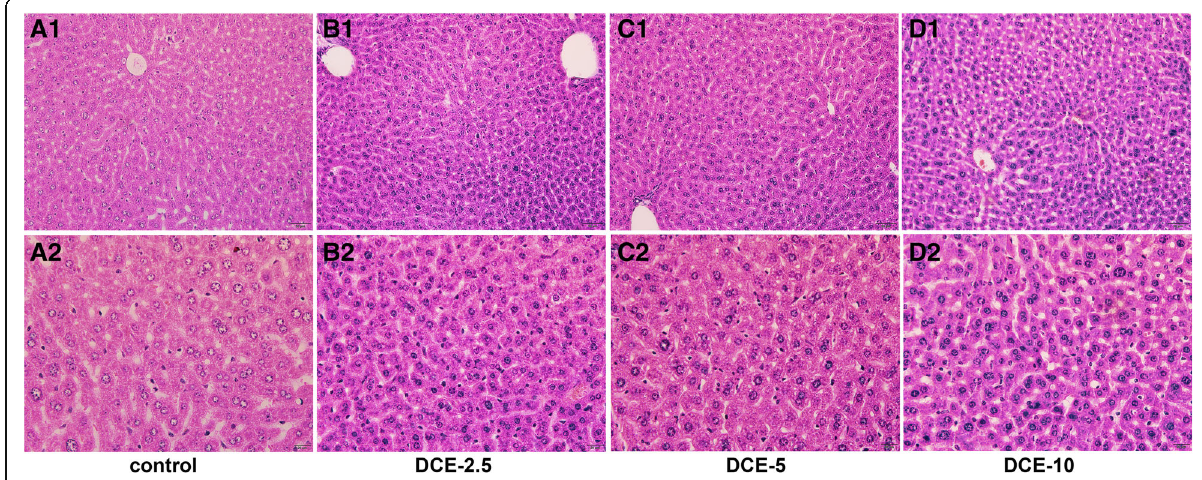
Fig. 1 Photomicrographs of mouse liver, hematoxylin and eosin stain. a Normal mouse liver. b Mouse liver treated with DCE-2.5, denoting hypertrophic hepatocytes with increased nuclear heterochromatism. c Mouse liver treated with DCE-5 had hypertrophic hepatocytes, which formed thick hepatic cords. d In the livers of mice treated with DCE-10, hepatocytes were slightly shrunken and aligned, and sinusoidal spaces were